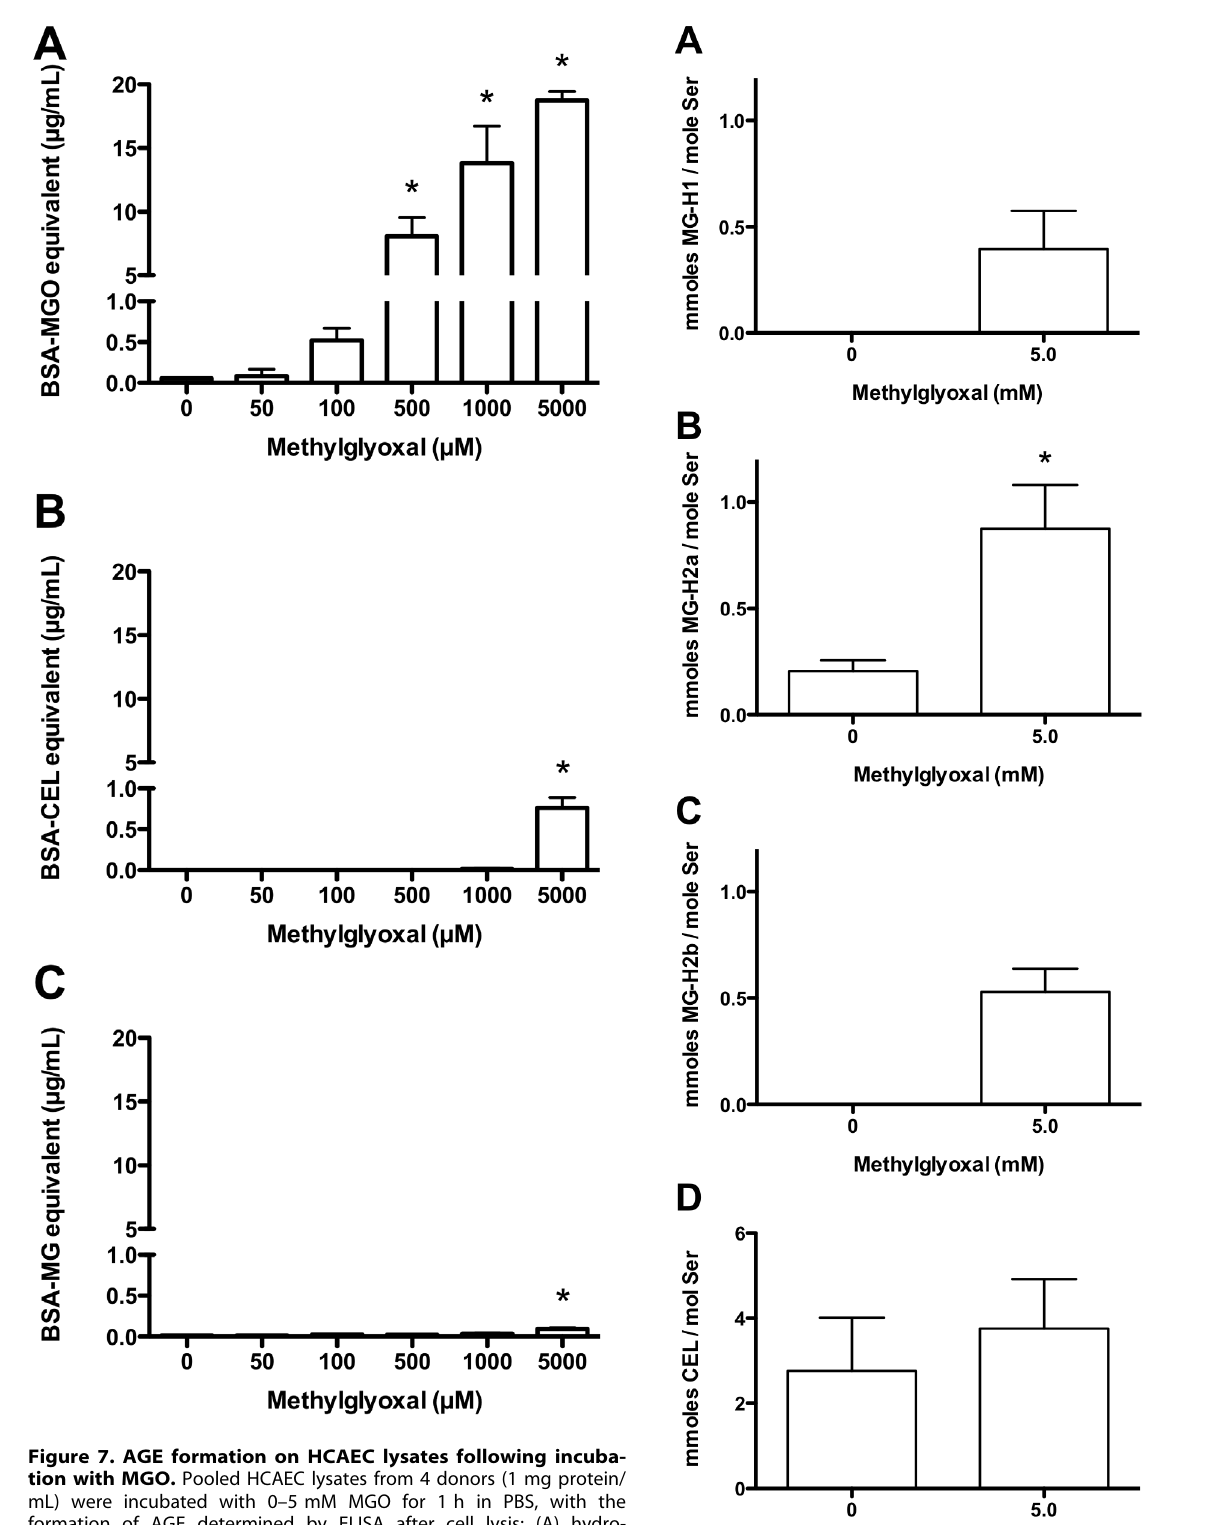
Figure 8. HPLC identification and quantification of AGE formation on HCAEC lysate proteins following incubation with MGO. HCAEC lysates (1 mg protein/mL) were incubated for 3 h with 0– 5 mM MGO, followed by HPLC separation and analysis. (A) MG-H1, (B)